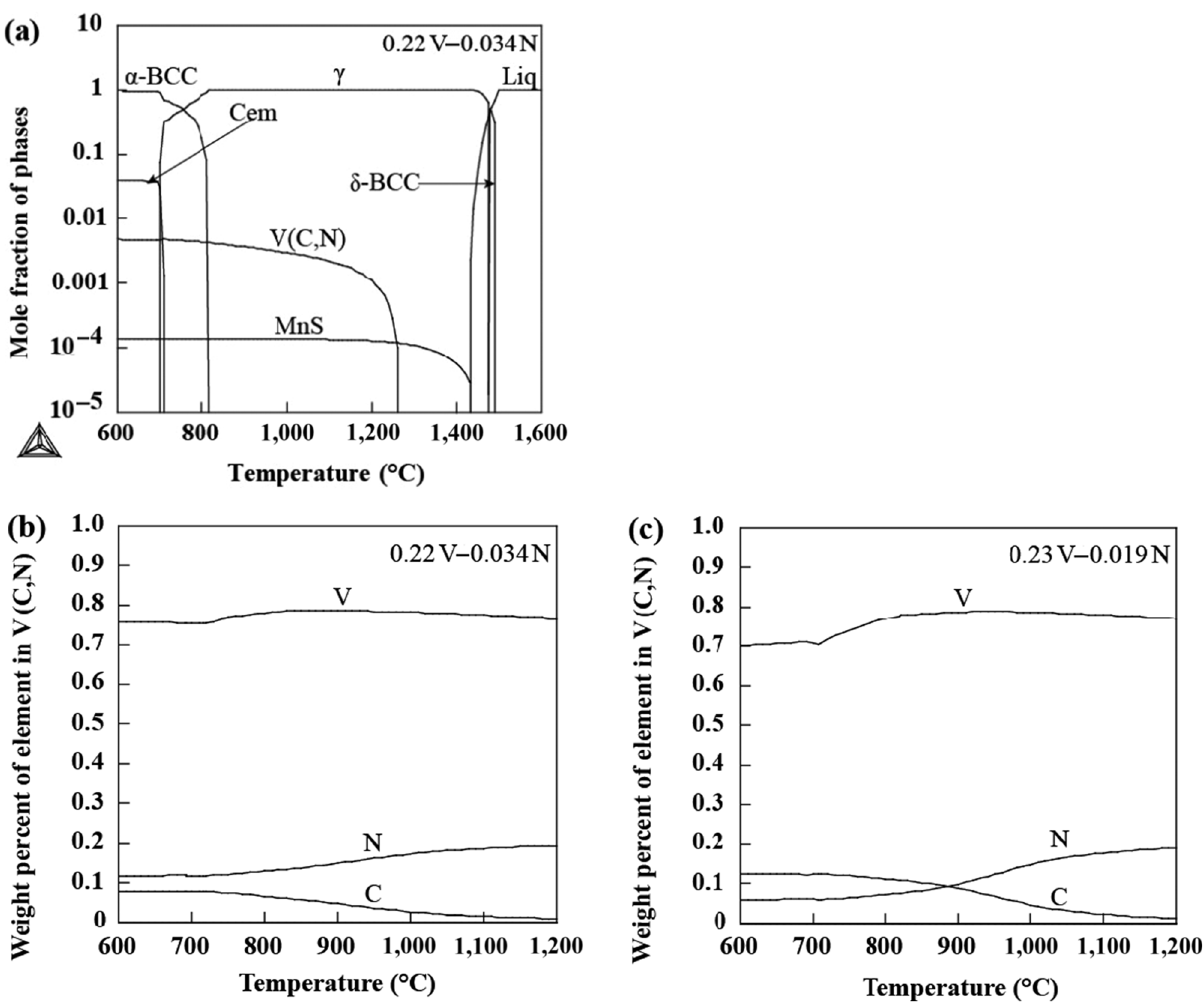
Figure 2: (a) The calculated mole fraction of phases for the experimental steel VN3, 2(b) and 2(c) weight percent of elements in V(C,N) for the experimental steels VN3 and VN1 as a function of temperature.